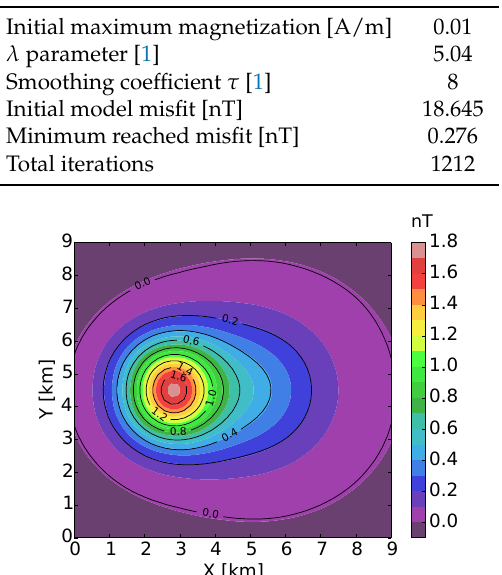
Figure 21. Initial (colour map) and inverted (contour lines) magnetic response for the S